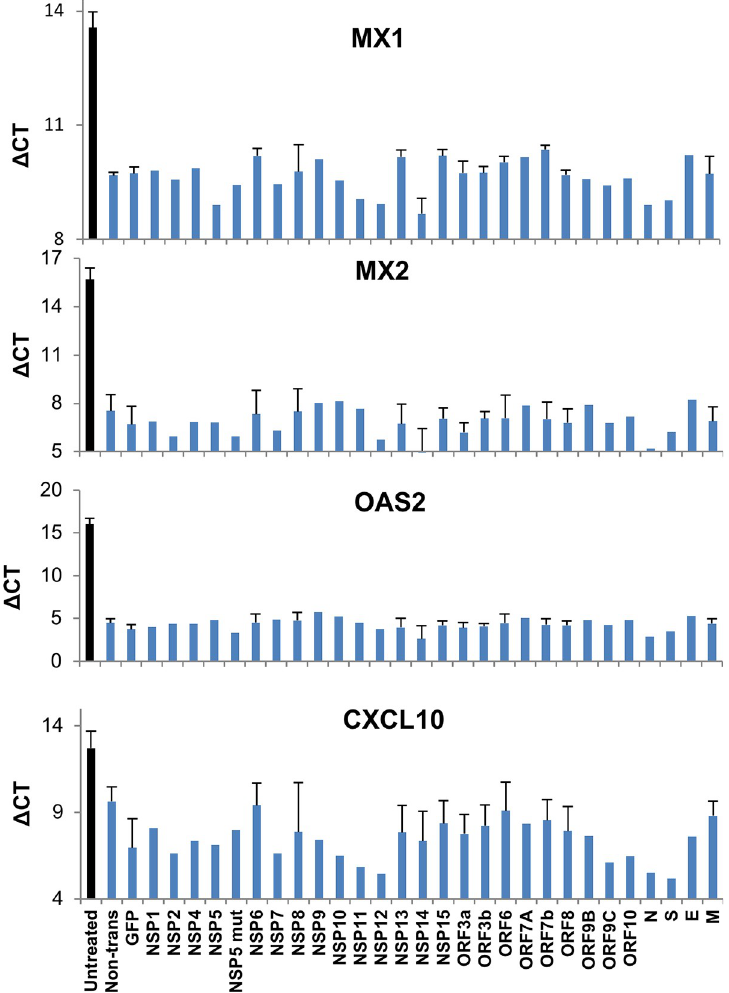
calculated based on 2–3 independent